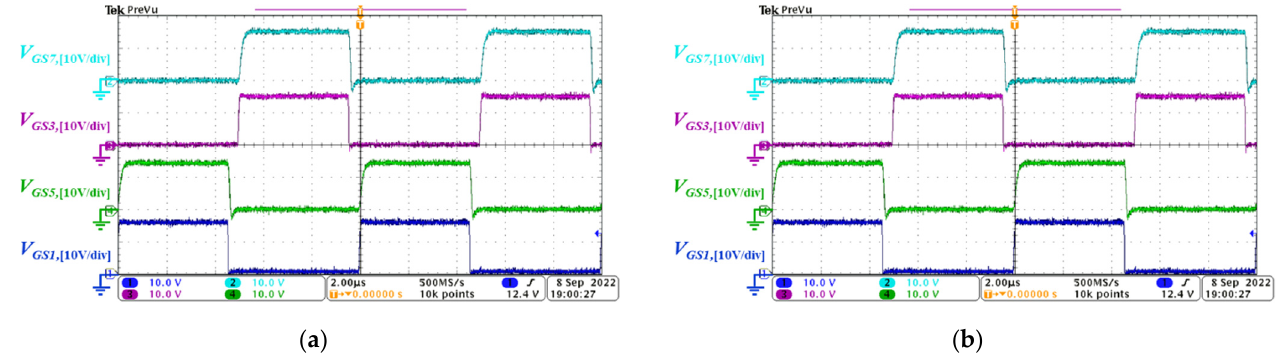
Figure 12. Experimental waveforms of the prototype converter operating in forward power conver- sion mode (at 10 W output power): ( a ) waveforms of gate signals V GS1 , V GS3 , V GS5 and V GS7 ; ( b ) waveforms of gate signals V GS1 , V GS3 , and inductor current i LK .